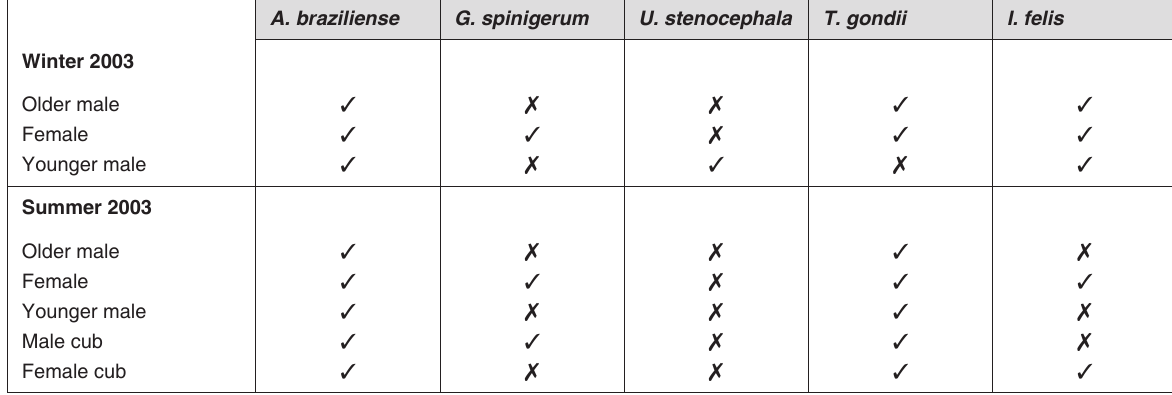
TABLE 1 Endoparasite suprapopulation in African lions during two contrasting periods of study at Intu Afrika Kalahari Game Reserve